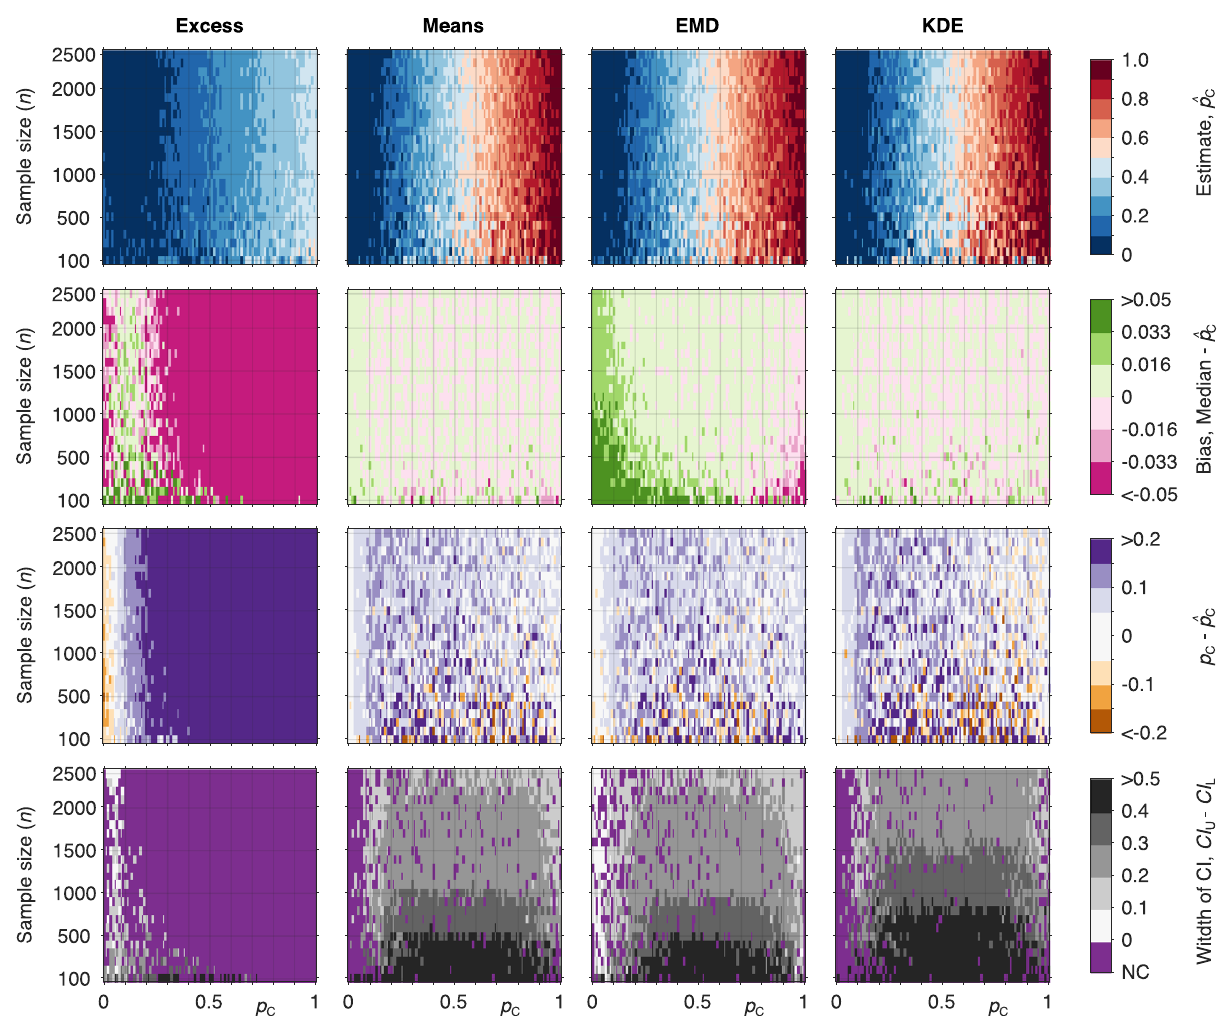
Fig. 3 A comparison of the four methods with prevalence estimates and con fi dence intervals for varying proportion of disease and cohort sizes using the (Type 2 GRS) from the WTCCC dataset: T1D n ¼ 1 ; 963 ð Þ ; T2D ð n ¼ 1 ; 924 Þ . (Top row) Estimate of prevalence ( ^ p C ) in the constructed mixtures. (Second row) Bias of the prevalence estimates ( ^ p C ) across the constructed mixtures. (Third row) Deviation from the true proportion ( p C (cid:2) ^ p C ) across the constructed mixtures. (Bottom row) The width of con fi dence intervals ( CI U (cid:2) CI L ) of the estimates across the constructed mixtures. The purple colour (bottom row) indicates regions in which the con fi dence interval did not include the true value ( p C ), CI L ¼ CI U or the con fi dence interval was unde fi ned (both latter cases can happen if ^ p C ¼ 0 or ^ p C ¼ 1). Sample sizes: R C – cases WTCCC T2D ( n ¼ 962), R N – non-cases WTCCC T1D ( n ¼ 982), mixtures – sampled with replacement from a hold-out half of the R C ( n ¼ 962) and R N ( n ¼ 981) samples; see “ Methods ”